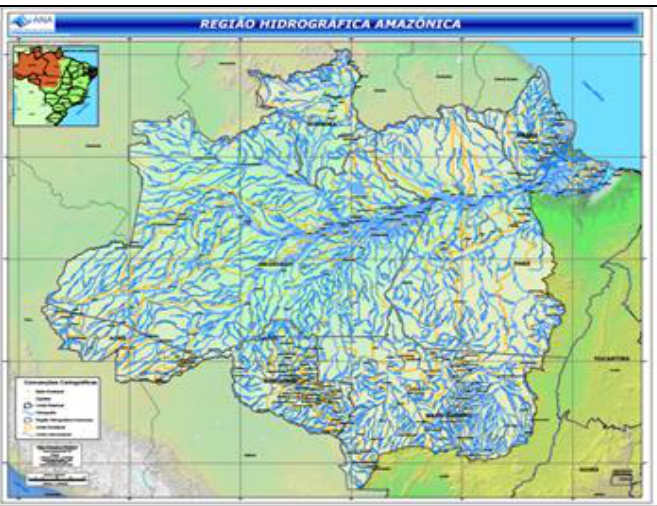
Figura 1: Mapa da localização da bacia hidrográfica do Amazonas. Fonte: